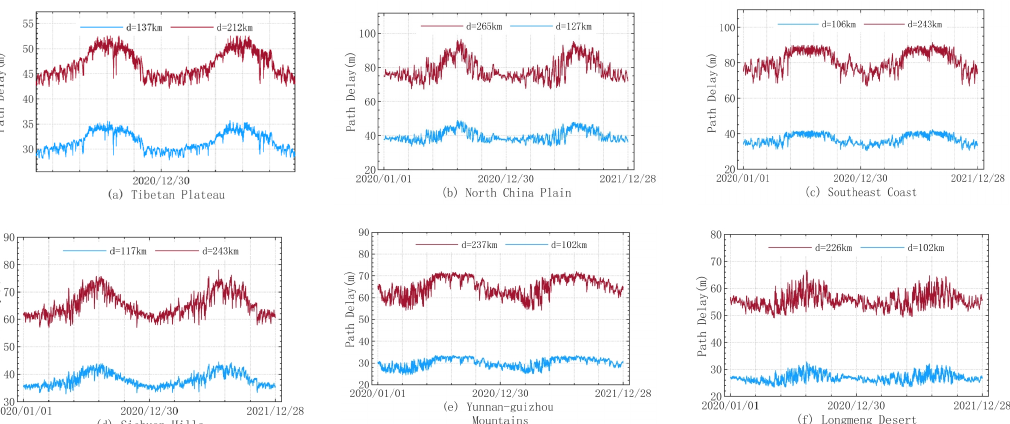
Figure 5. Scattered propagation path delays for 12 links. These six subfigures show the path delay of 12 links in di ff erent regions: ( a ) Tibetan Plateau, ( b ) North China Plain, ( c ) Southeast Coast, ( d ) Sichuan Hills, ( e ) Yunnan–guizhou Mountains, ( f ) Longmeng Desert.